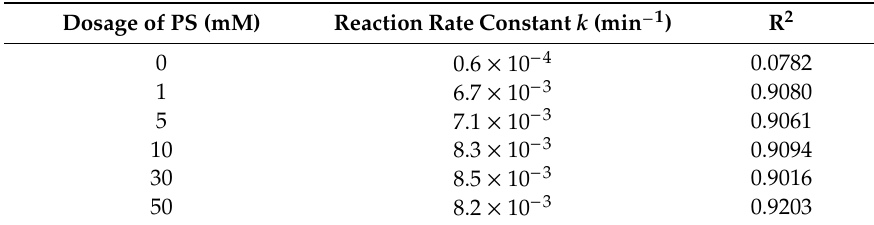
Table 2. The reaction rate of tetracycline degradation at di ff erent dosages of persulfate.